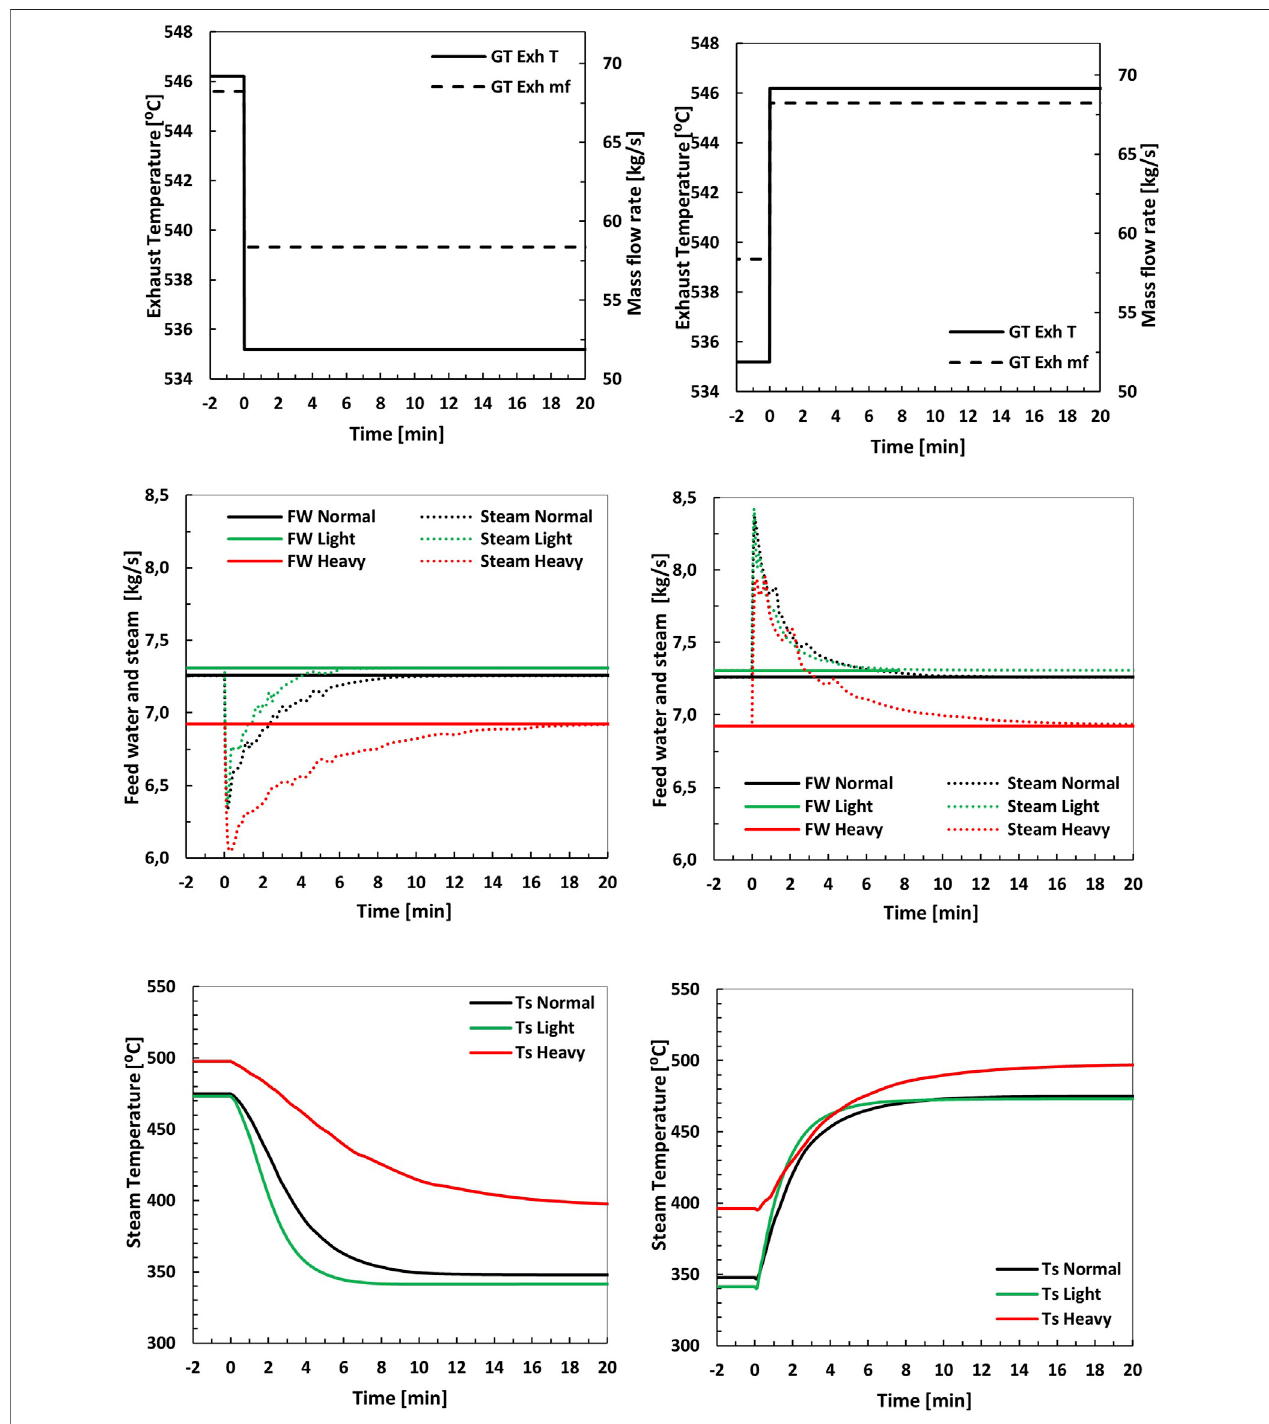
FIGURE 9 | Dynamic simulation results for Scenario 2. The process variables shown are (A, B) exhaust gas fl ow rate and temperature; (C, D) feedwater fl ow rate and live steam mass fl ow rate; and (E, F) live steam temperature.